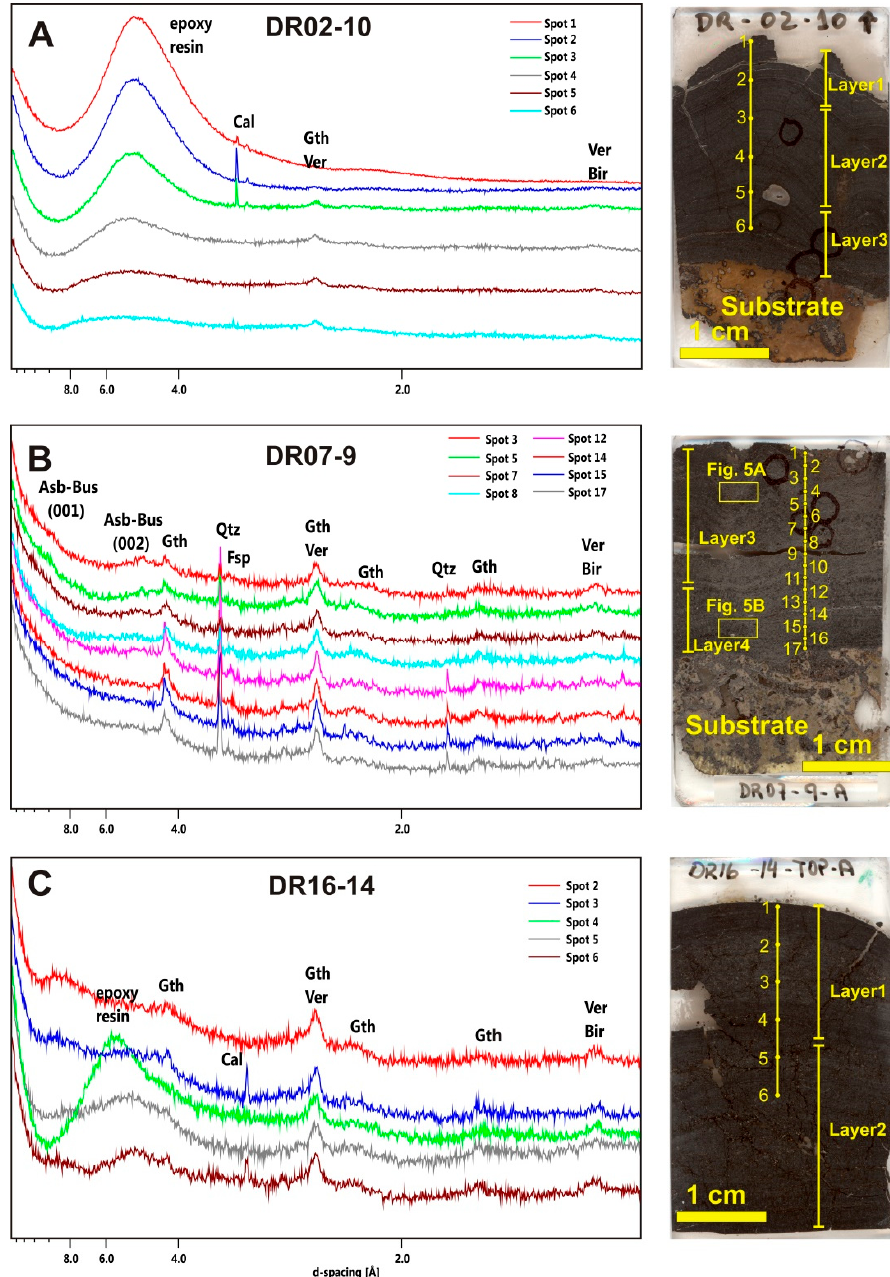
Figure 5. ( A – C ) micro-XRD analyses (left) on polished cross thin sections (right) in transect from 0 to 24 mm are shown. In all samples, the different reflections belong to Fe and Mn oxyhydroxides (Fe-vernadite, birnessite and goethite); ( B ) in spots 3 and 5 of sample DR07-9, the reflections belong to asbolane/buserite. Circles in the figure are interesting areas analyzed with Raman, FT-IR and EPMA. Spectra 1, 2, 4, 6, 9, 10, 11, 13, 16 in B and spectrum 1 in C have been avoided due to their similarity with those chosen in the figure.